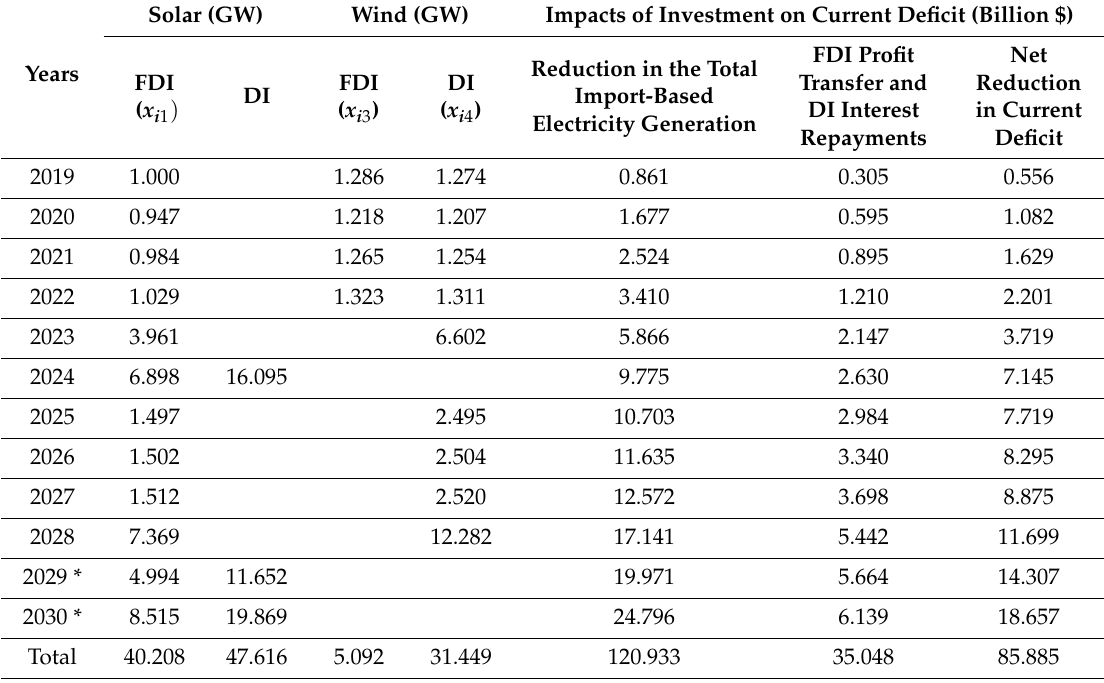
Table 3. Turkey 2019–2030 solar and wind energy optimum investment